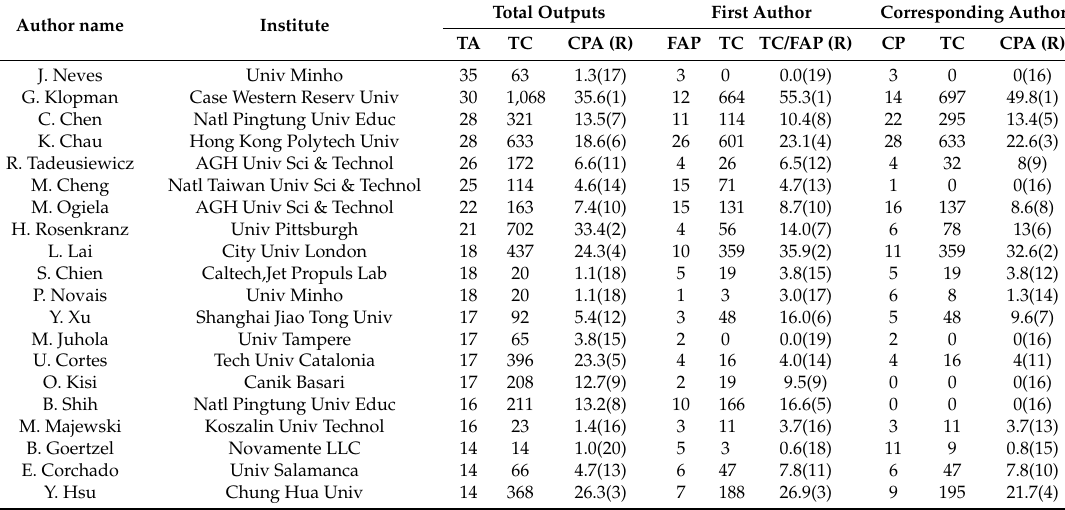
Table 3. Top 20 productive authors from 1990–2014.